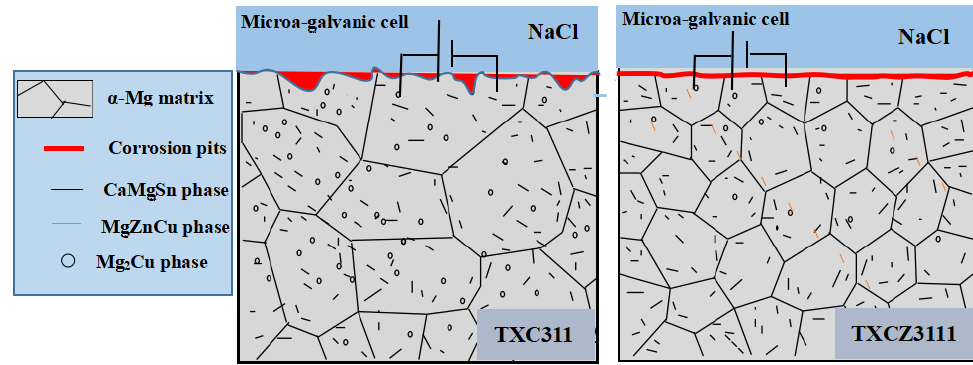
Figure 7. Schematic corrosion mechanism diagram of TXC311 and TXCZ3111 alloy.